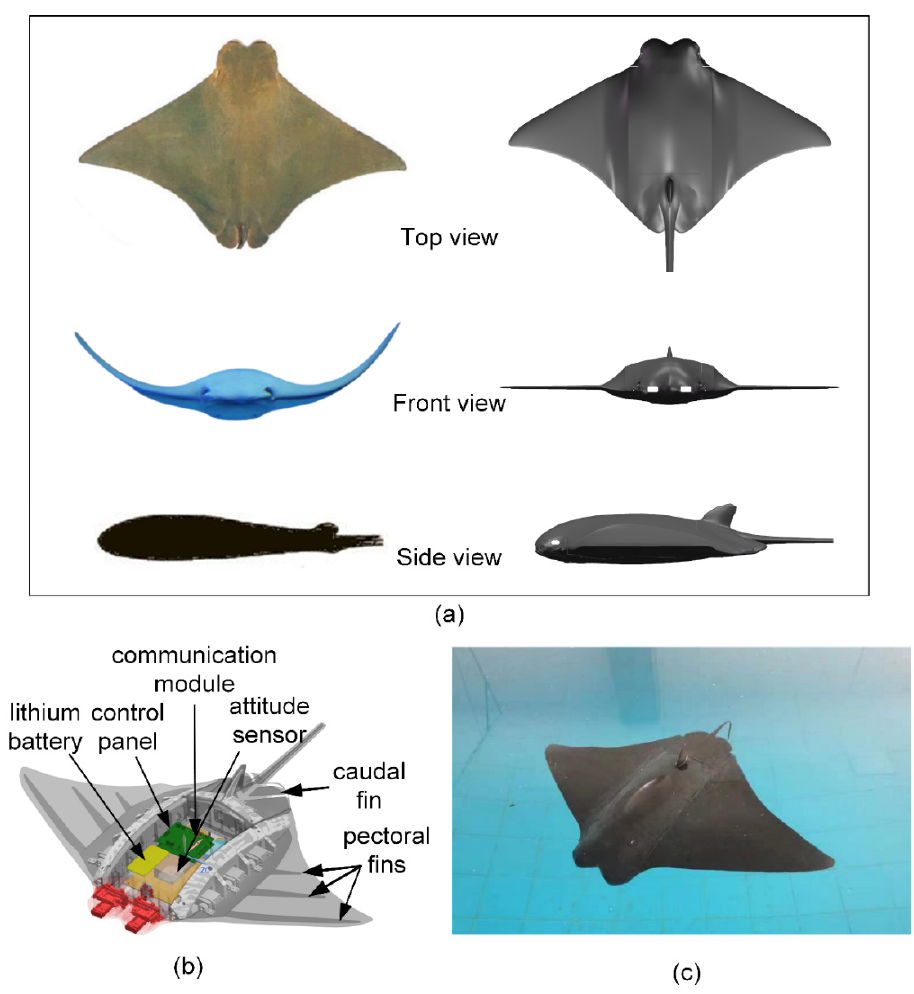
Figure 3. Manta ray robot design and build: ( a ) Three-view comparison of the manta ray robot and a manta ray; ( b ) The structure of the robot; ( c ) A physical photo of the manta ray robot in the pool.